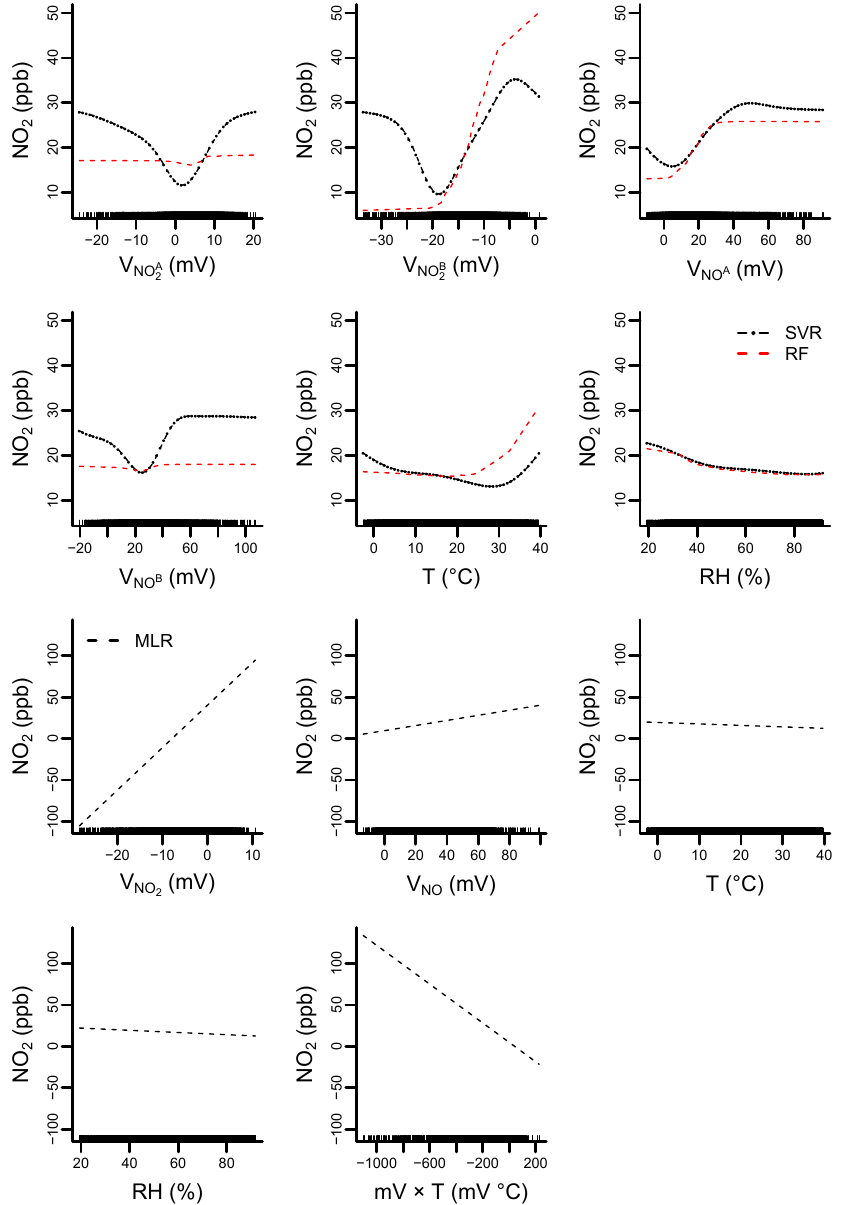
Figure 2. Partial plots for SVR, RF and MLR for the calibration dataset from SU009, NO 2 . Rug on the abscissa indicates the range of the